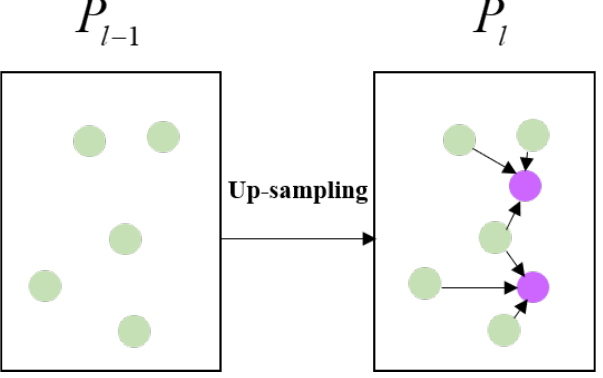
Figure 9. Decoder layer: distance-based weighted linear interpolation up-sampling.